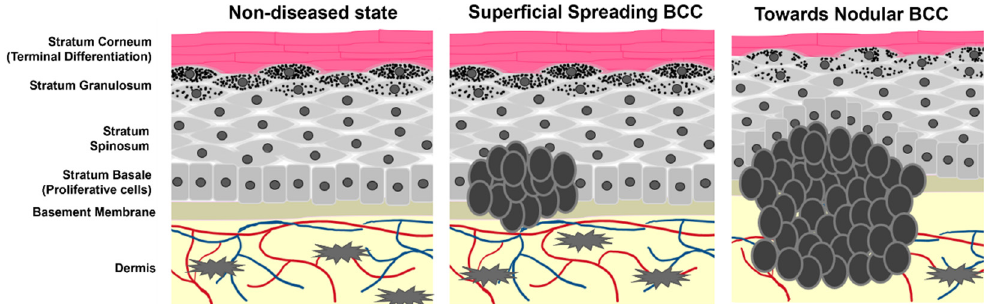
Scheme 1. Cartoon representation of epidermal layers and the growth of BCC. Tumor cells originate from the stratum basale where they maintain stemness and hyperproliferative capacity. As the tu- mors progress, they begin to spread and migrate into the dermis as well as alter the pathology of non-tumor keratinocyte